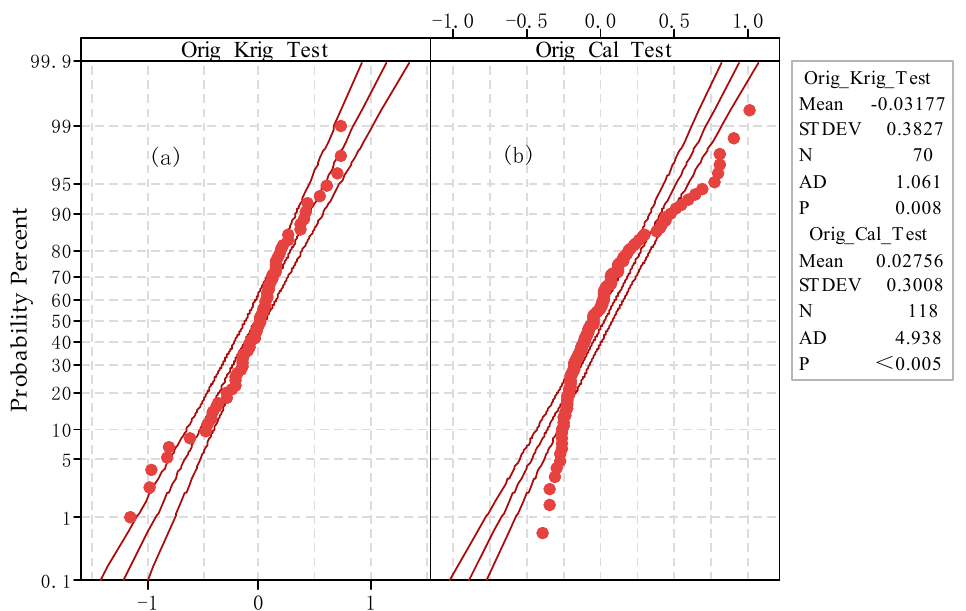
Figure 2. Anderson – Darling (A – D) tests of the original difference data: ( a ) initial and ( b ) calibrated Figure 2. Anderson–Darling (A–D) tests of the original di ff erence data: ( a ) initial and ( b ) calibrated kriging model. Figure 2. Anderson–Darling (A–D) tests of the original difference data: ( a ) initial and ( b ) calibrated kriging model. kriging model.